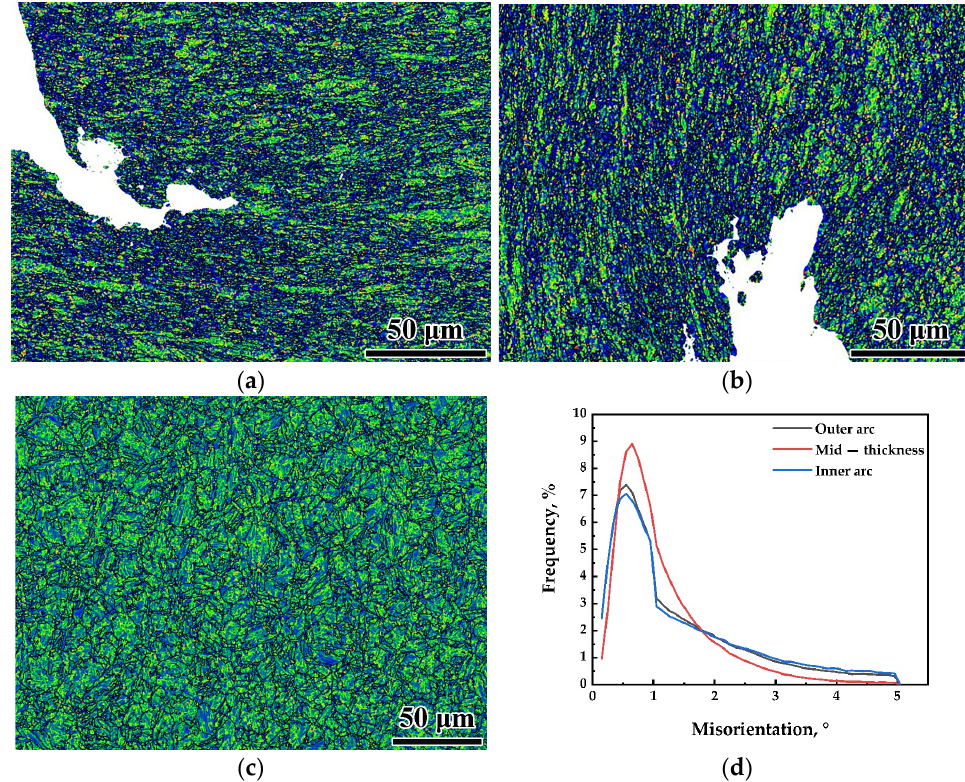
Figure 9. The kernel average misorientation (KAM) maps at the bending axis of the 5% Ni steel: ( a ) outer arc surface, ( b ) inner arc surface, ( c ) mid-thickness, and ( d ) distribution of KAM. The grain boundary misorientation maps of the samples are shown in Figure